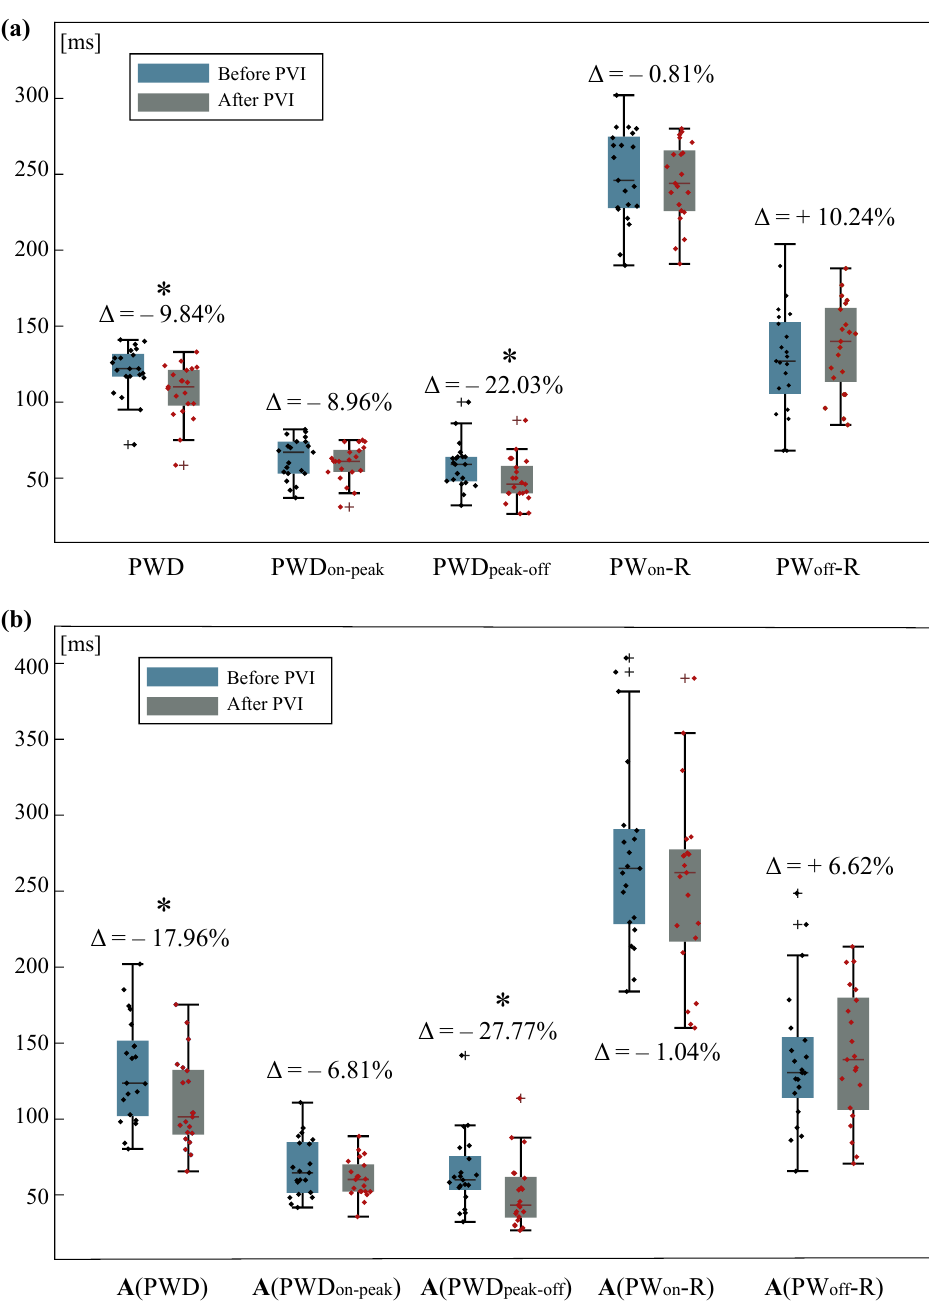
Figure 3. Boxplot with scatterplots for the analyzed features before and after PVI. ( a ) Boxplots for raw features. ( b ) Boxplots for scaled features according to the correction factor. The symbol ( • ) stands for normal values whereas (+) stands for outliers. Variation due to PVI ( ∆ ) is additionally shown. Significant variations are shown in ( ∗